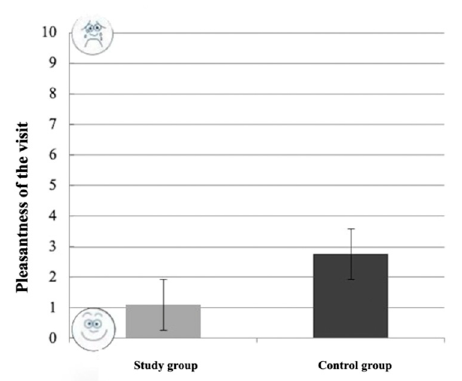
Figure 4. Reported pleasantness of the visit by children in the two groups .